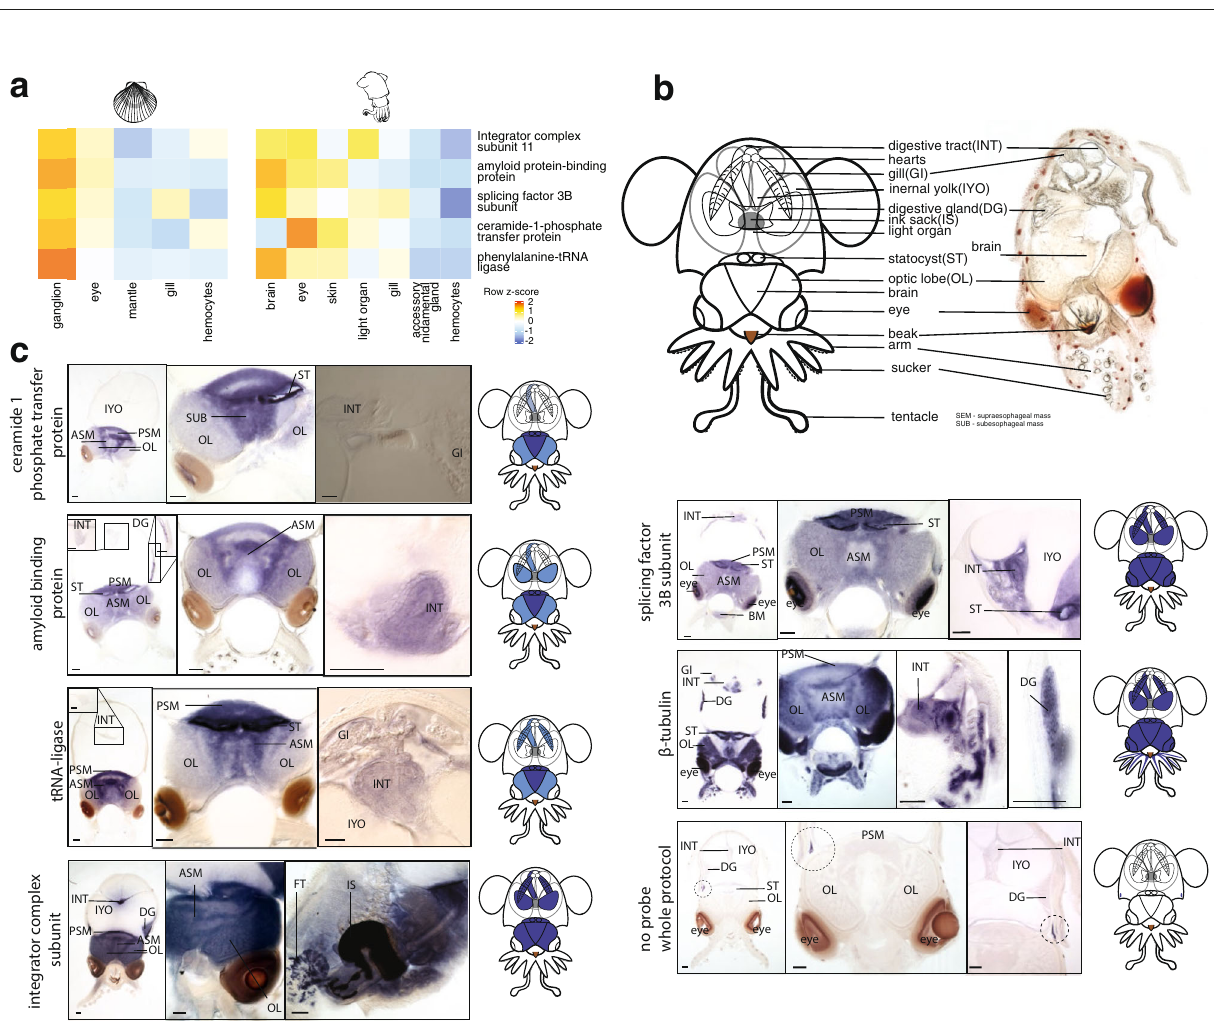
Fig. 4 Emergence of compact clusters and their unique expression patterns in nervous tissues. a Location of orthologous genes of one of the MACIs in Mizuhopecten yessoensis. The genes are located on two separate chromosomes (top — whole chromosome, bottom — zoom in, black — gene density, blue — location of orthologous genes) with many intervening genes in-between. Scallop orthologs of genes in the microsyntenic cluster are plotted at the bottom highlighted in blue. b Genes of the same cluster in Euprymna scolopes . The genes (highlighted in blue) are tightly packed on one chromosomal scaffold with only one intervening gene (top — whole chromosomal scaffold, bottom — zoom in, orange — conserved, metazoan microsyntenic clusters, blue — cephalopod- speci fi c microsyntenic clusters). The cluster is located within a TAD. Two major ATAC-seq peaks are present in intronic regions of the last gene of the cluster in three developmental stages (y-axis — signal value). RNA-seq read count of three developmental stages shows several small peaks in the region of the cluster (y-axis — read count). Early-stage — early organogenesis, stage 20, middle stage — late organogenesis, stage 24/25, late stage — close to hatching, stage 28/29. c Three-dimensional reconstruction of chromosomal scaffold 2. The cephalopod-speci fi c syntenic cluster is located on the surface. Left and right views are shifted by 90°.